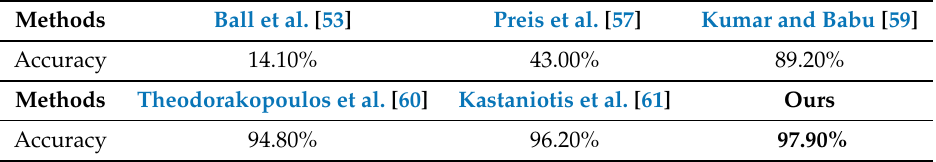
Table 2. Recognition rate of all individual recognition methods tested with the UPCVgait database.